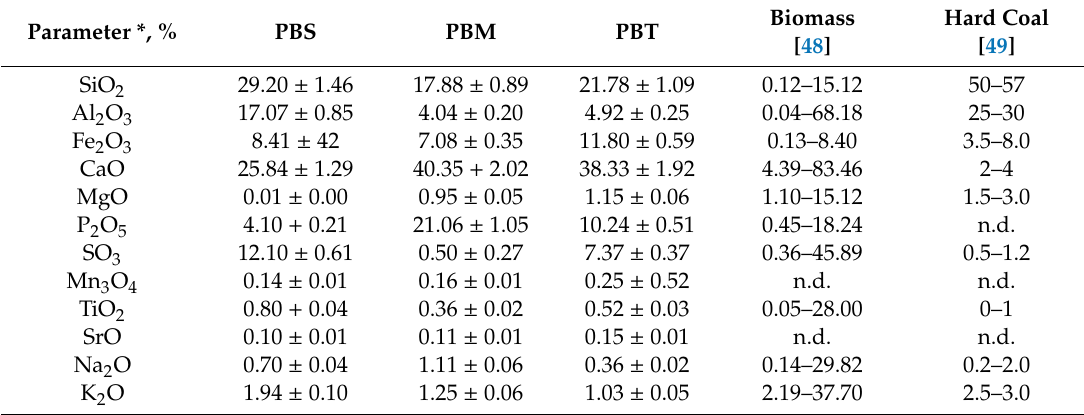
Table 3. Chemical composition of ashes.